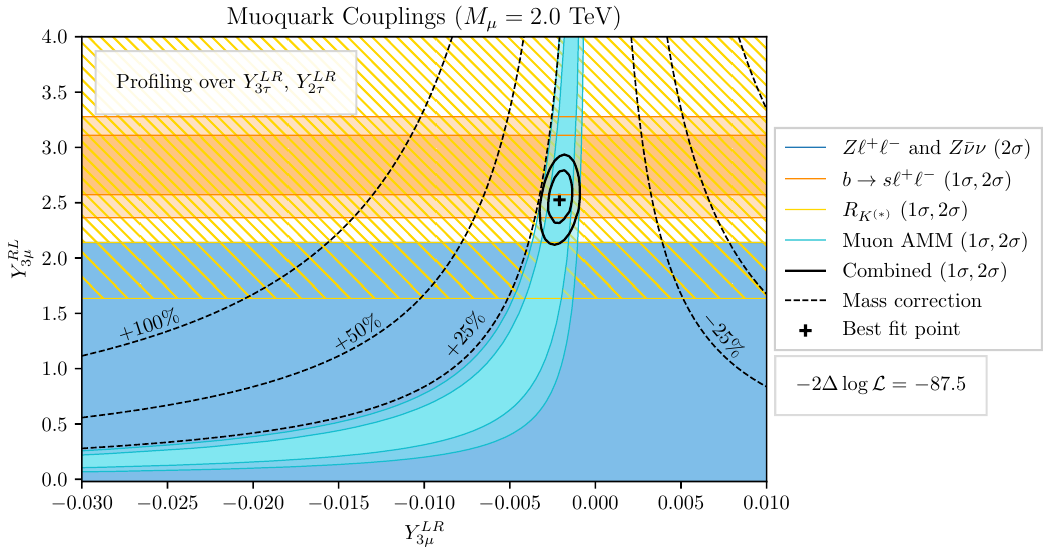
(light blue) anomalies, as µ , Y LR , Y RL and Y LR . We additionally show 3 τ 2 τ 3 µ 3 µ